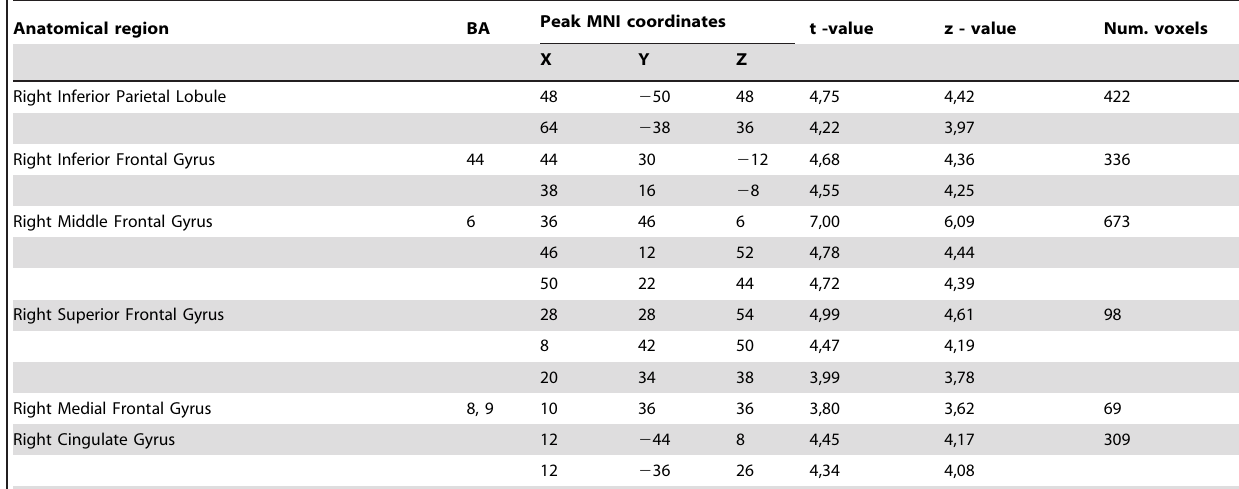
Anatomical region BA Peak MNI coordinates